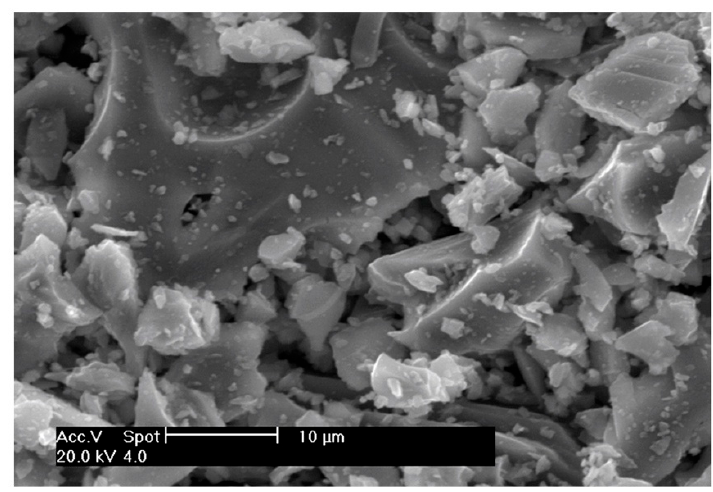
Figure 2. SEM micrograph of volcanic powder.